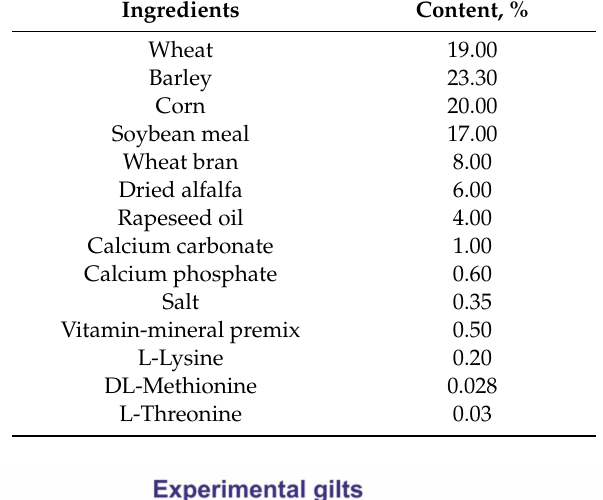
Table 1. Composition of feed mixture used for sows during high pregnancy and lactation.